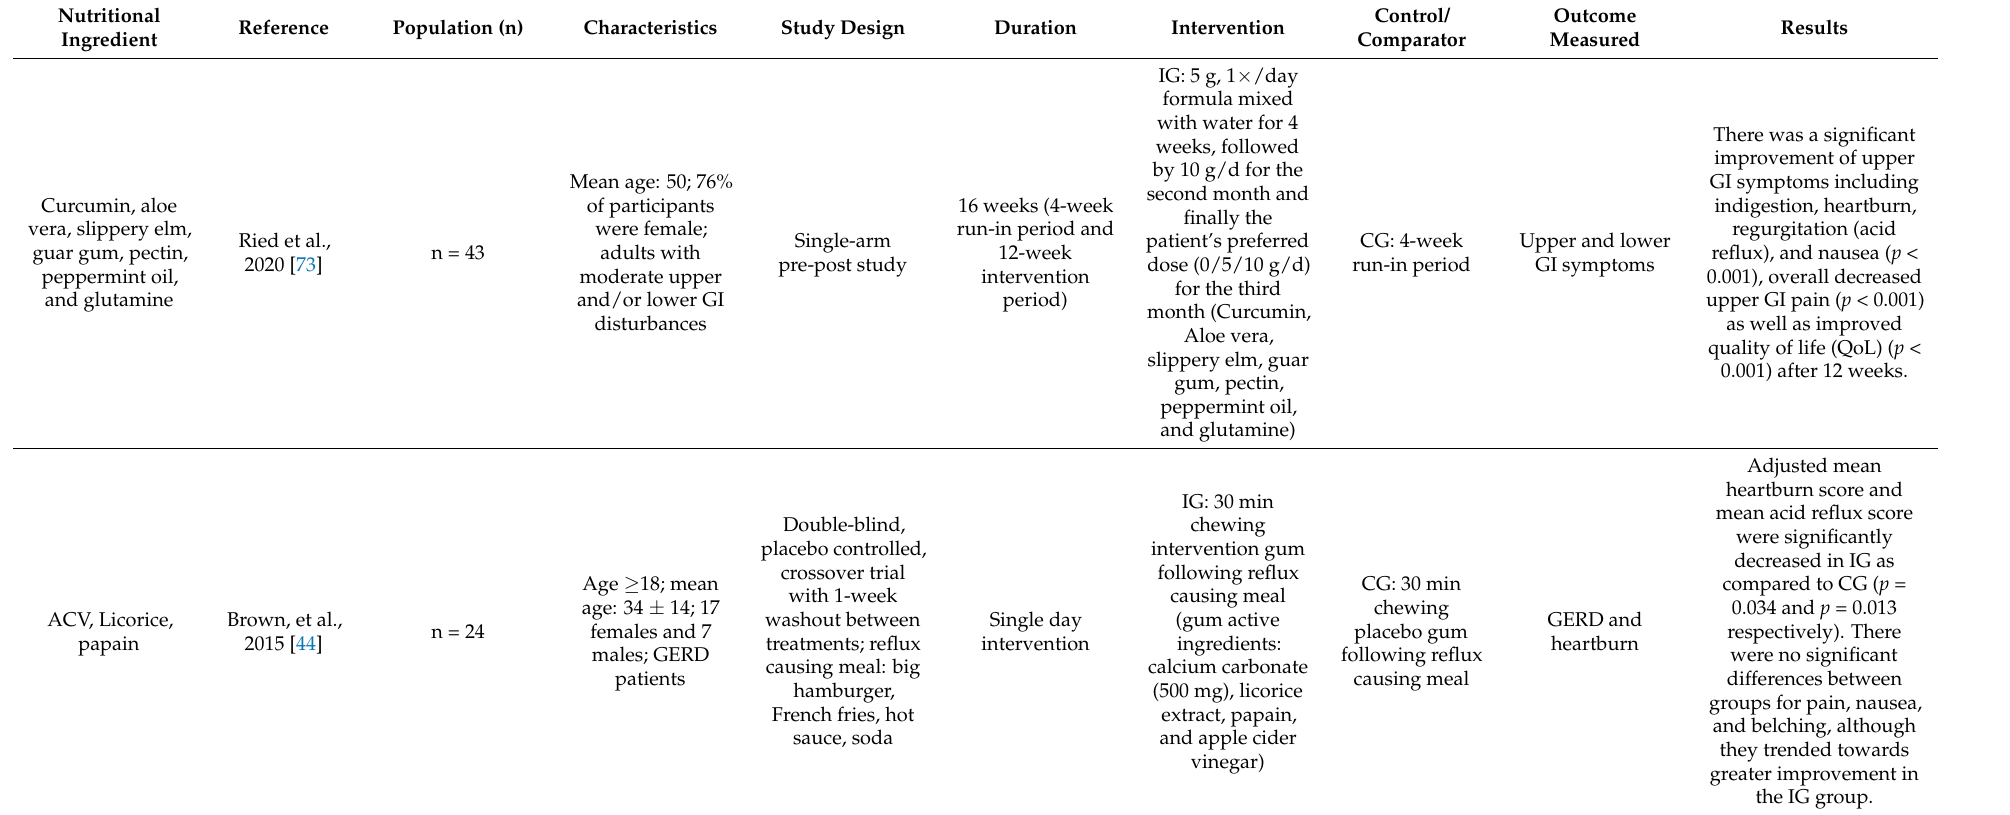
Table 6. Summary of human trials on botanical combination ingredients and upper GI